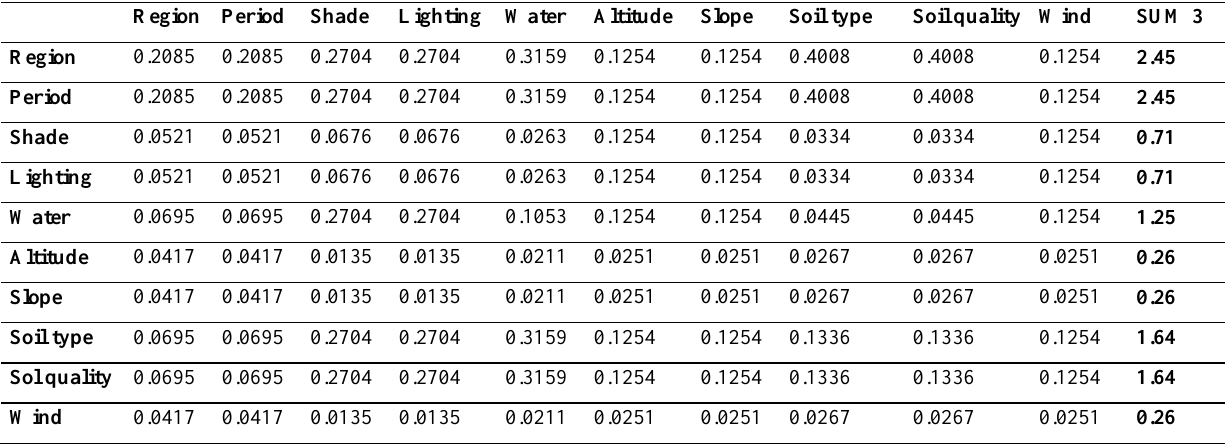
Table 5. Non-normalized comparison matrix multiplied by the weight of the associated criteria